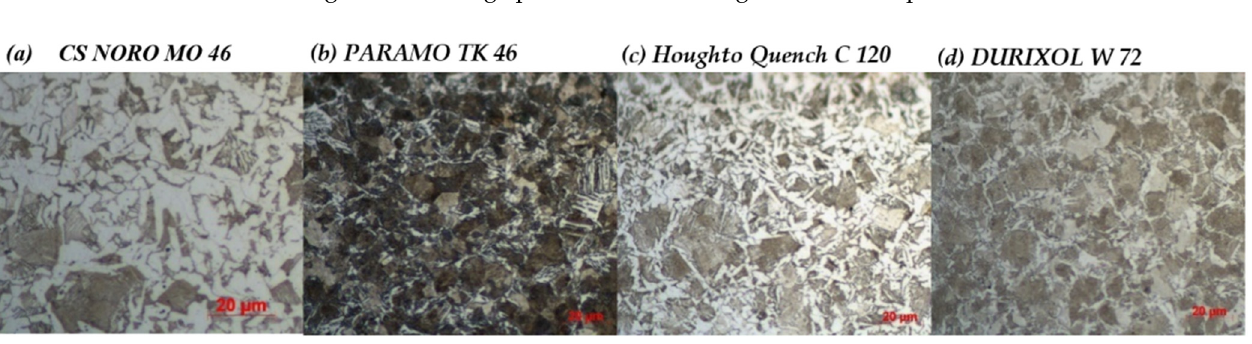
Figure 2. Microstructures in C35E steel at 1 mm below the surface. Quenched in oil. From the left: ( a ) CS NORO MO 46, ( b ) PARAMO TK 46, ( c ) Houghto Quench C 120, ( d ) DURIXOL W 72. Magnification 1000×.